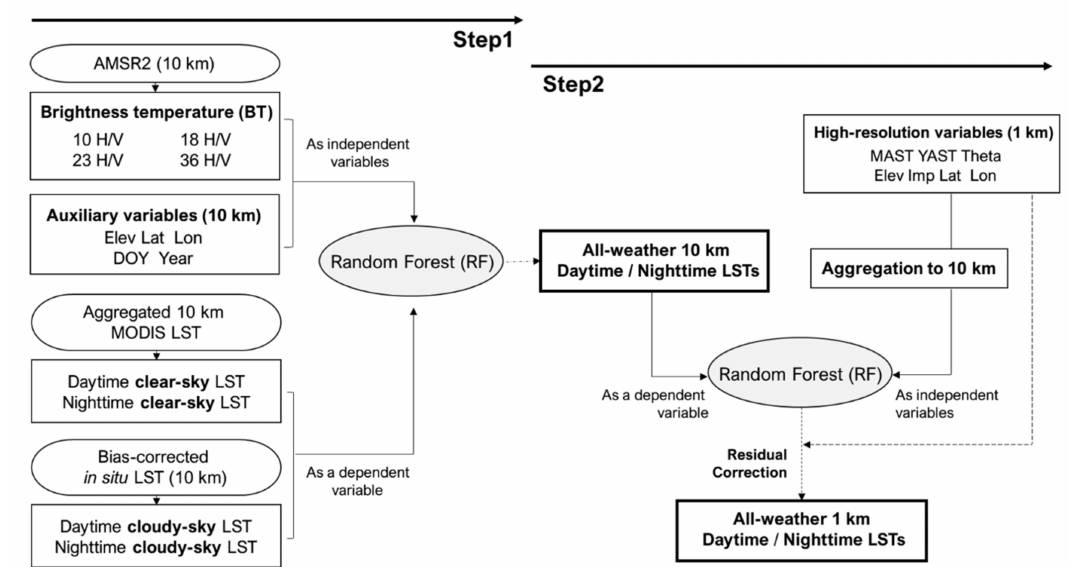
Figure 2. Flowchart of scheme 1(S1) suggested in this study. Procedures are divided into two main steps: Estimating 10 km land surface temperatures (LSTs) ( left ) and the spatial downscaling of LSTs to 1 km ( right